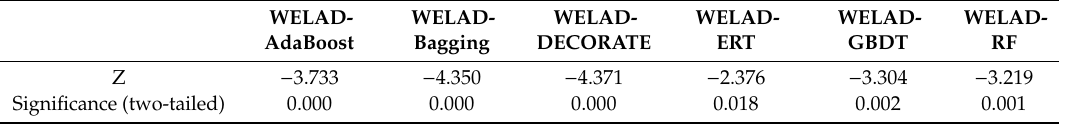
Table 6. Wilcoxon signed-rank